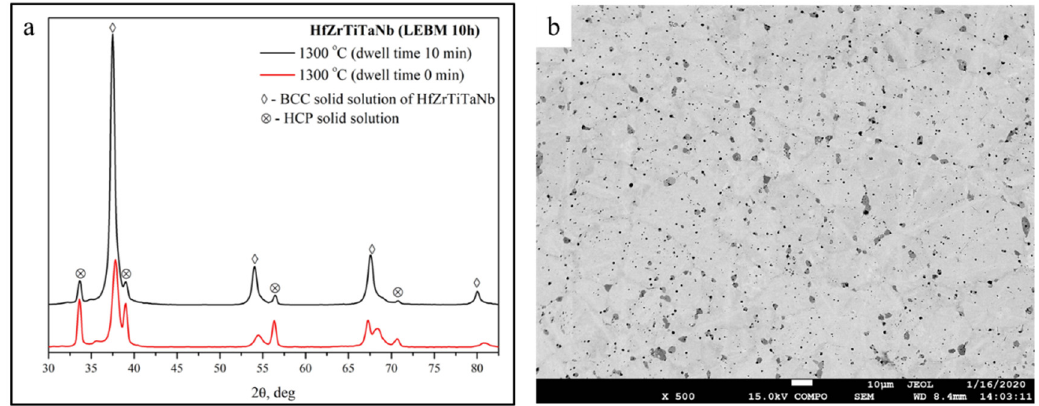
Figure 8. XRD patterns and SEM images of LEBM-processed (10 h) HfTaTiNbZr specimens sintered at 1300 °C with dwell time τ = 10 min ( a,b ) and τ = 0 min ( a ).